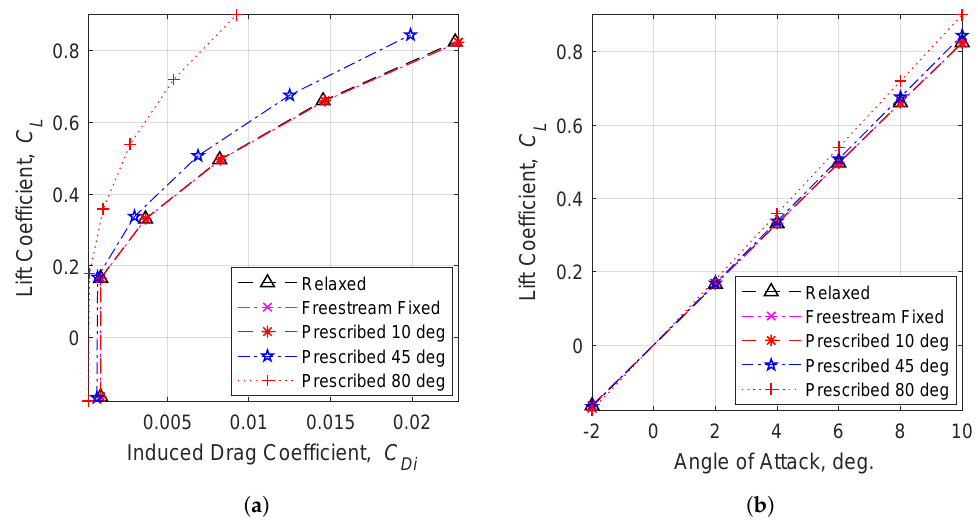
Figure 8. Aerodynamic predictions of a single rectangular wing, using five different wake shapes [5].